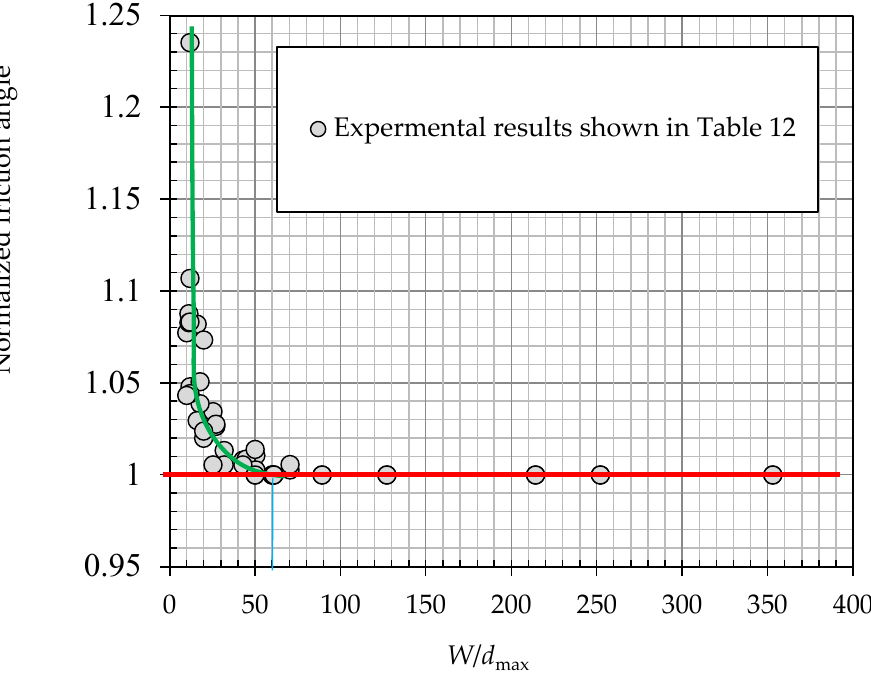
Figure 7. Variations of the normalized friction angles as a function of W / d max of the experimental results obtained in this study and taken from the literature. The minimum required specimen size is identified as W / d max = 60.